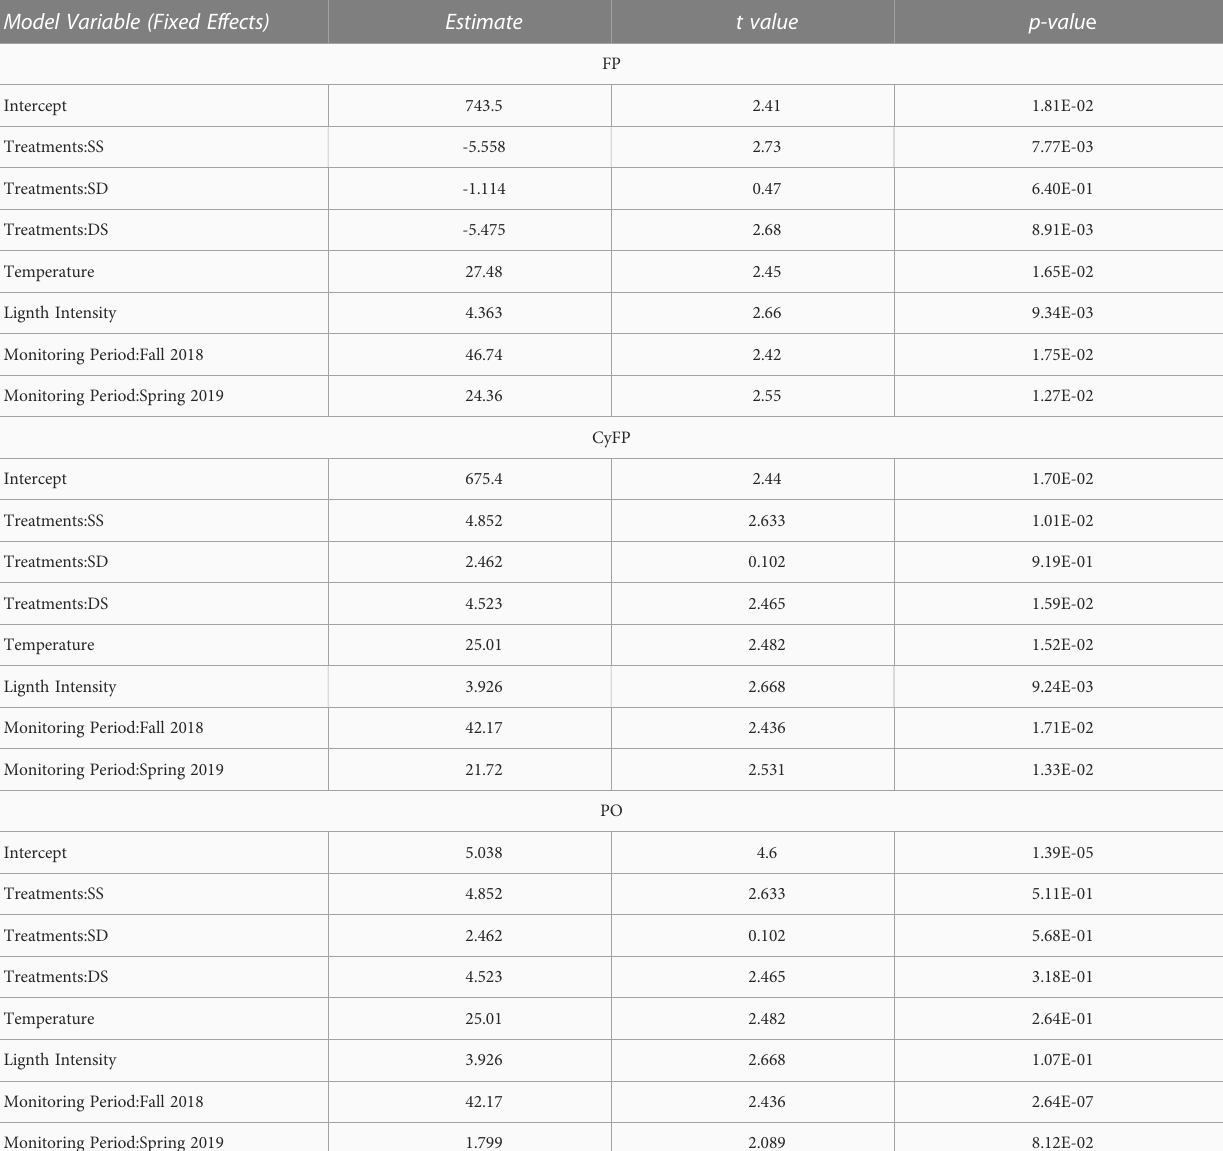
TABLE 3 Fixed effects result from the General Linear Mixed Model (GLMM) analyses for Green Fluorescent Protein (GFP), Cyan Fluorescent Protein (CyFP), and Phenoloxidase (PO) activity from control colonies fi tted by maximum likelihood t-test using Satterthwaite, p-value represents levels of signi fi cance; Deep-shallow experimental colonies (DS); Shallow-deep experimental colonies